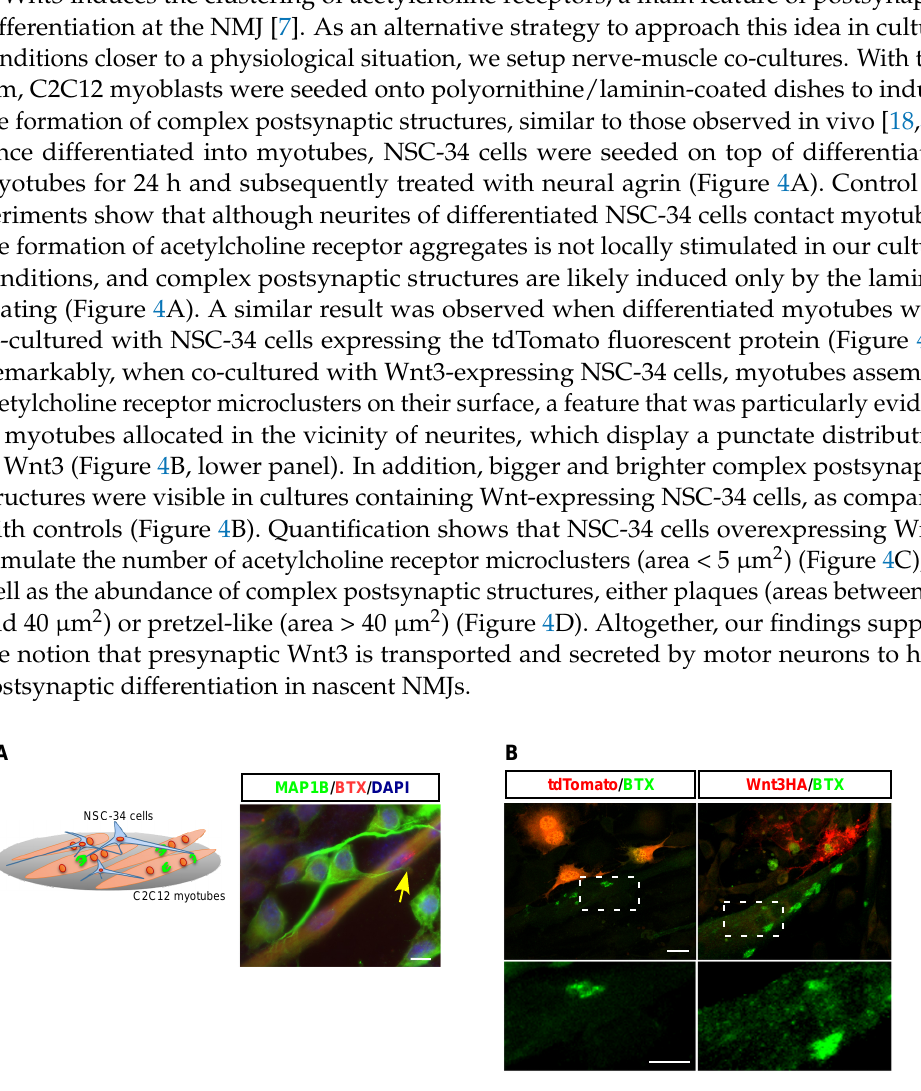
Clusters Complex postsynaptic structures